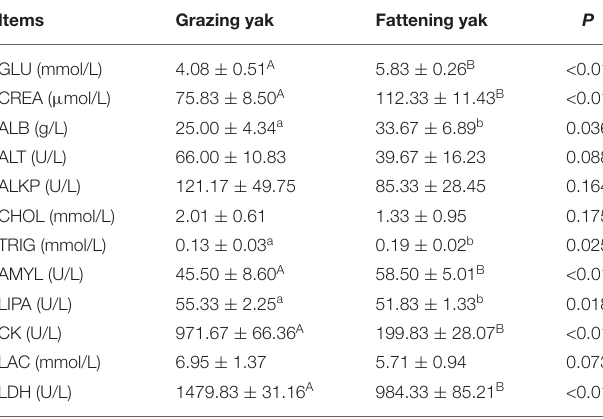
TABLE 6 | Effects of the intensive fattening with TMR on blood biochemical indexes of yak (mean ±